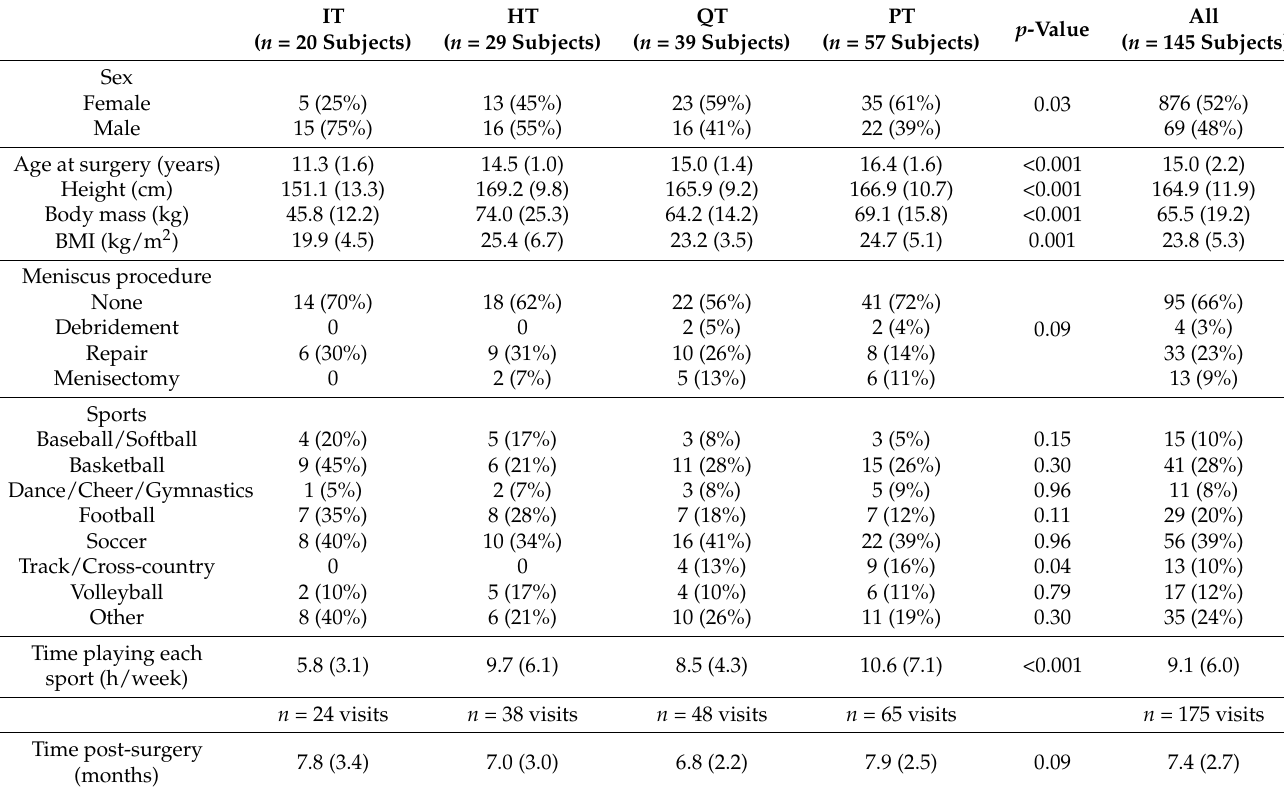
Table 1. Participant